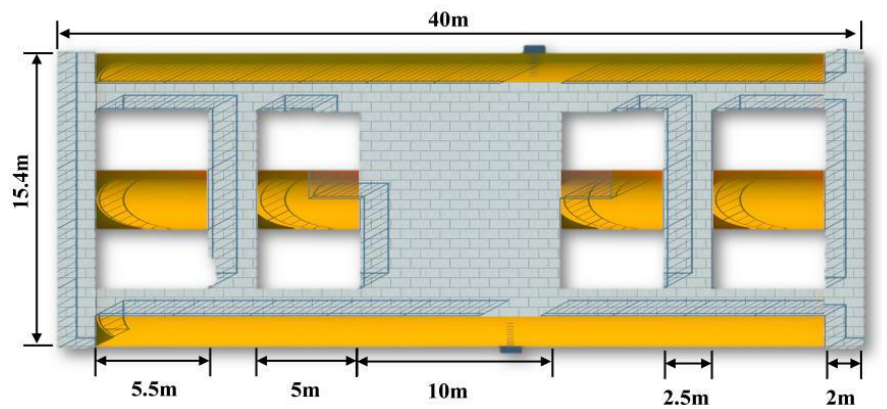
Figure 2. Dimensions of the three-cylinder floating breakwater.